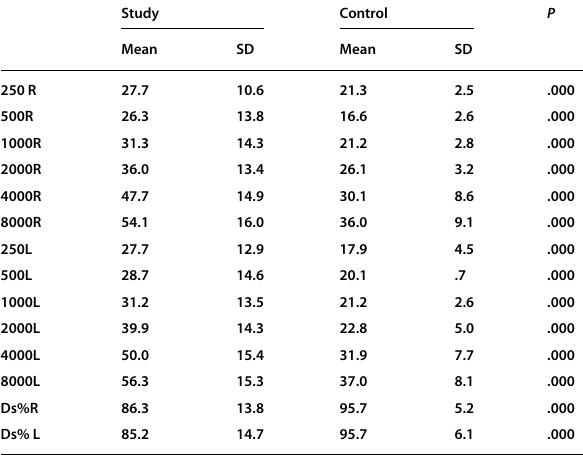
Table 7 Mean, SD, and t test of (PTA) hearing threshold levels across tested frequencies (250 Hz–4000 Hz) and Ds% in right and left ears in both study and control groups